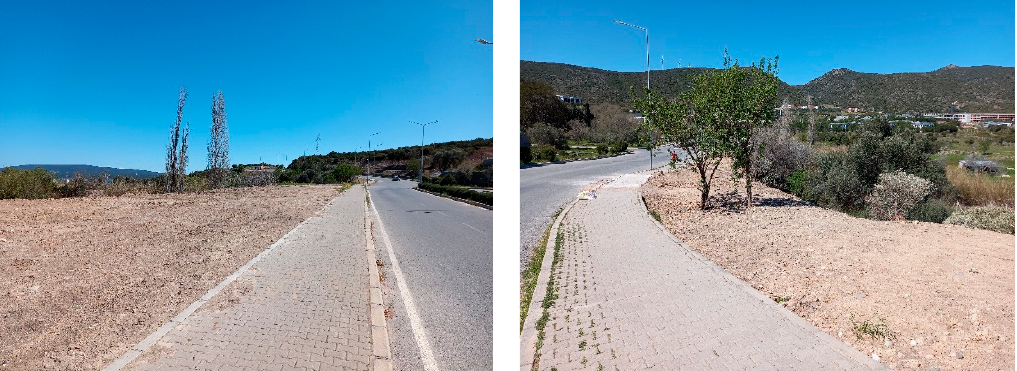
Figure 8. Creation of banks along the main road of the campus.